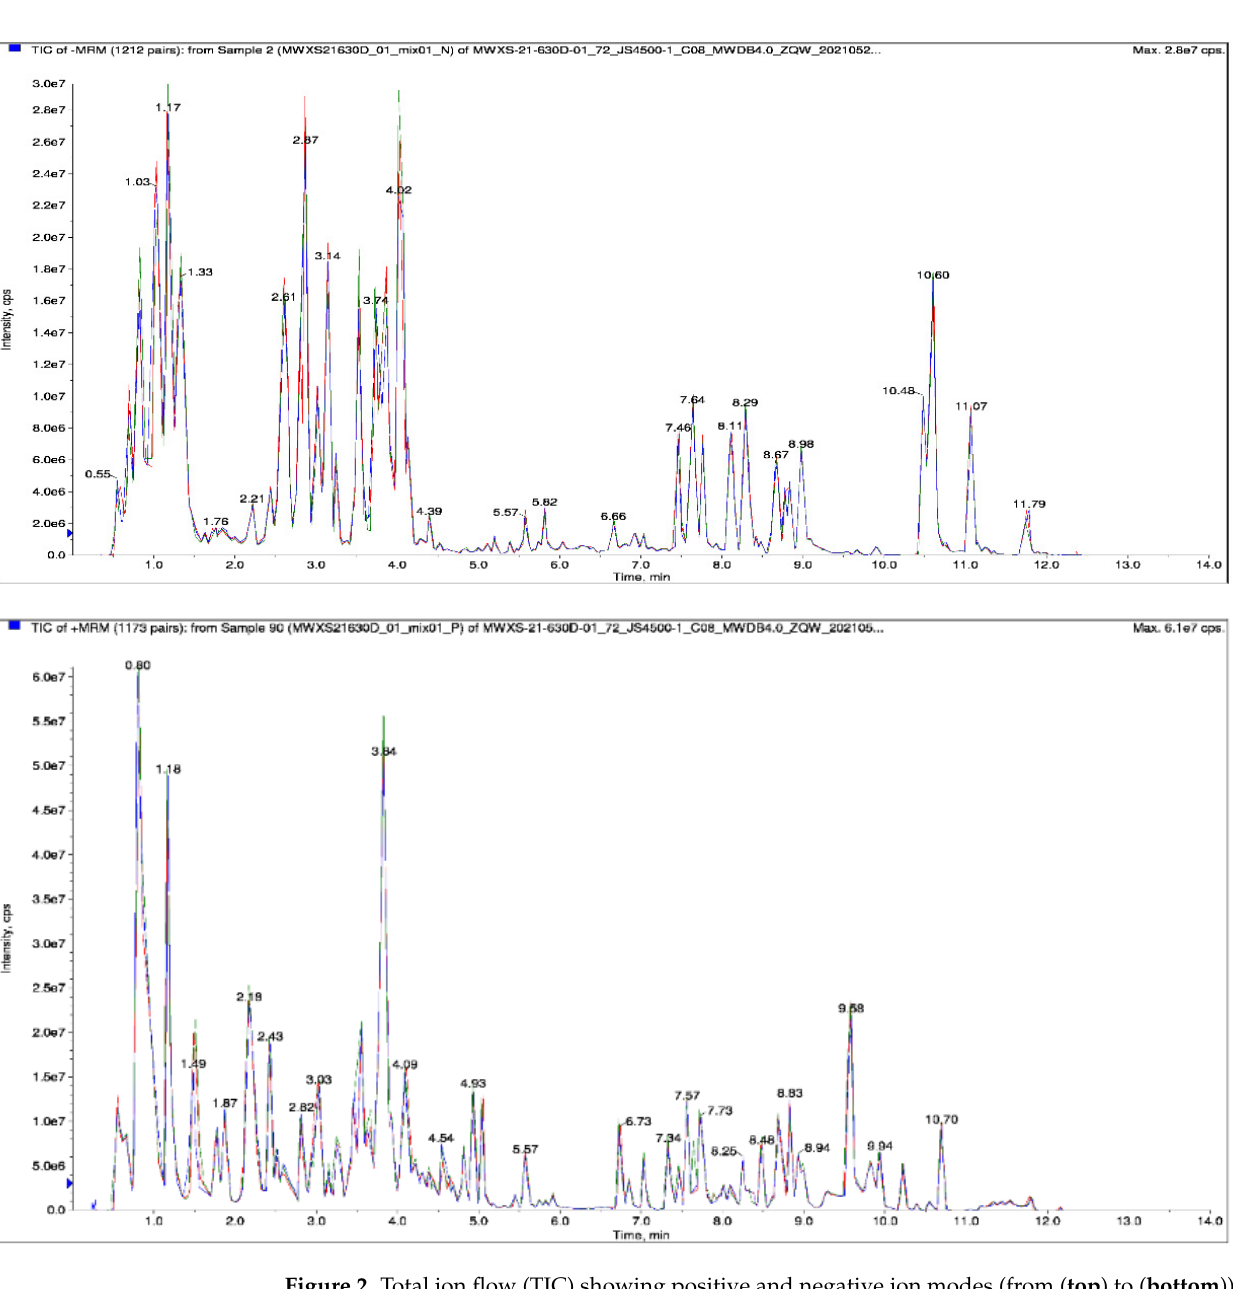
Figure 2. Total ion flow (TIC) showing positive and negative ion modes (from ( top ) to ( bottom )).